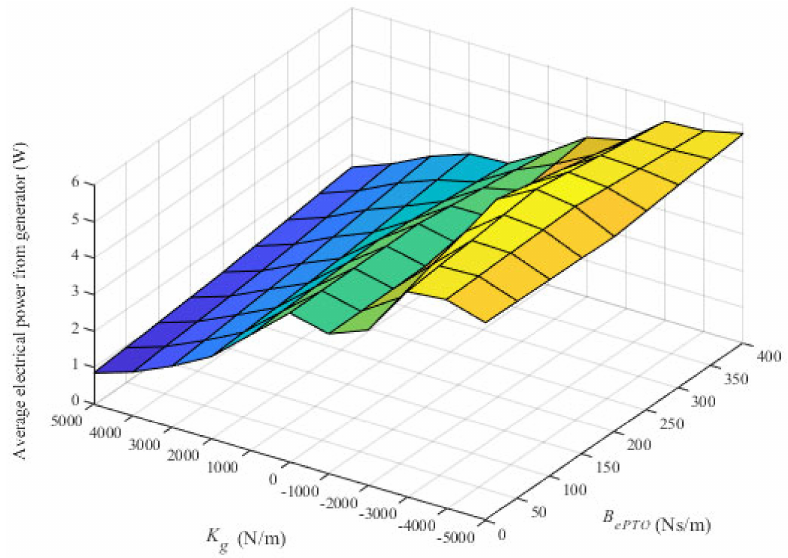
Figure 19. Electrical power when adjusting damping ( B ePTO ) and spring force ( k g ), H = 0.2 m, f = 0.3 to 0.6